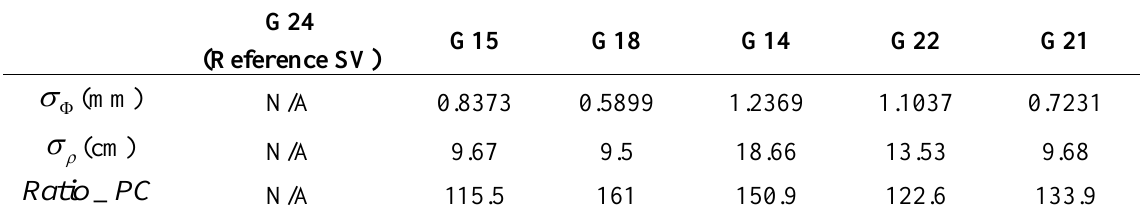
Table 3. Standard deviation of GPS code and phase observations in static experiments.